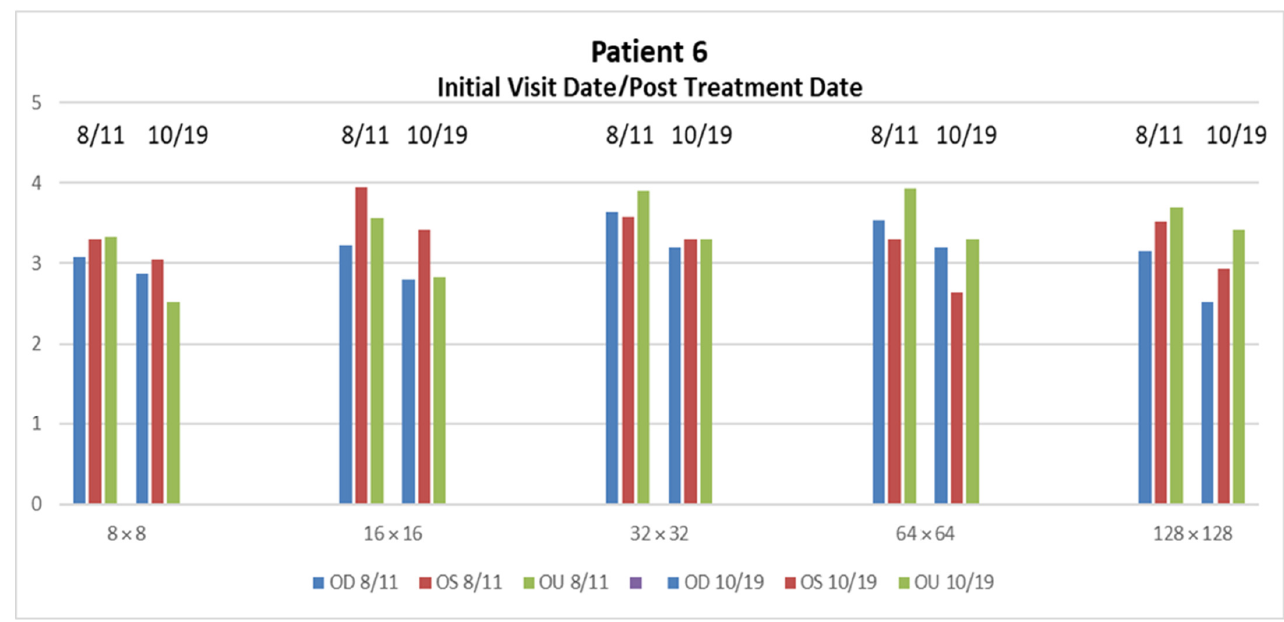
Figure 5. PSD reduction after two months in Patient 6 is seen 8 × 8 and 16 × 16 OU. The restoration of PSD values for these specific areas within the 2–3 range have shown to contribute to the meas-